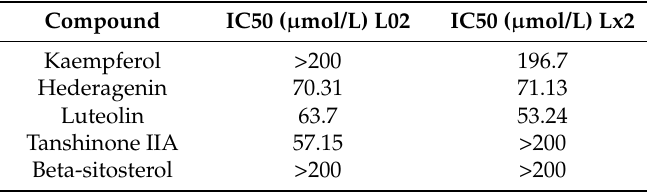
Table 1. IC50 values of major compounds for L02 and Lx2 cell lines.